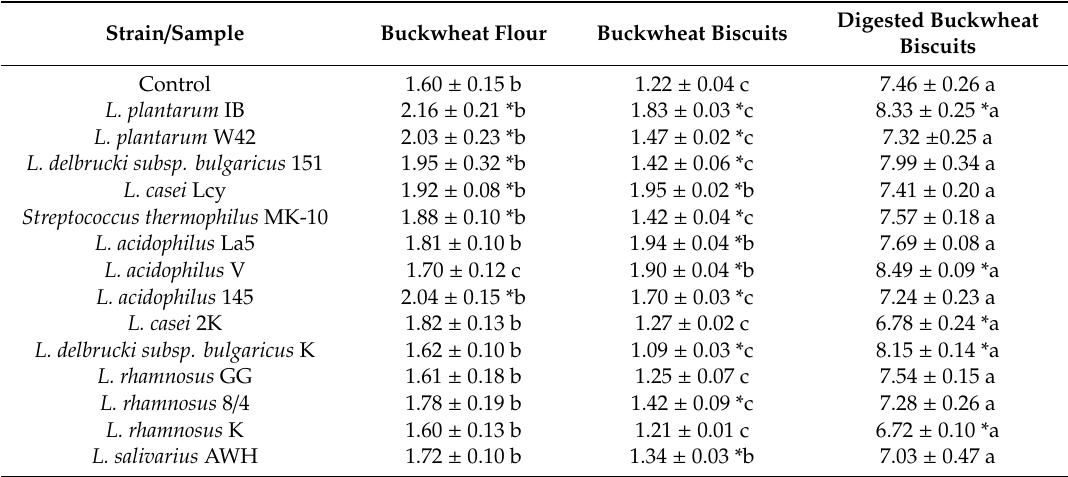
Table 2. The content of total phenolic compounds in fermented buckwheat flour and water biscuits before and after in vitro digestion (mg gallic acid equivalents (GAE) / g